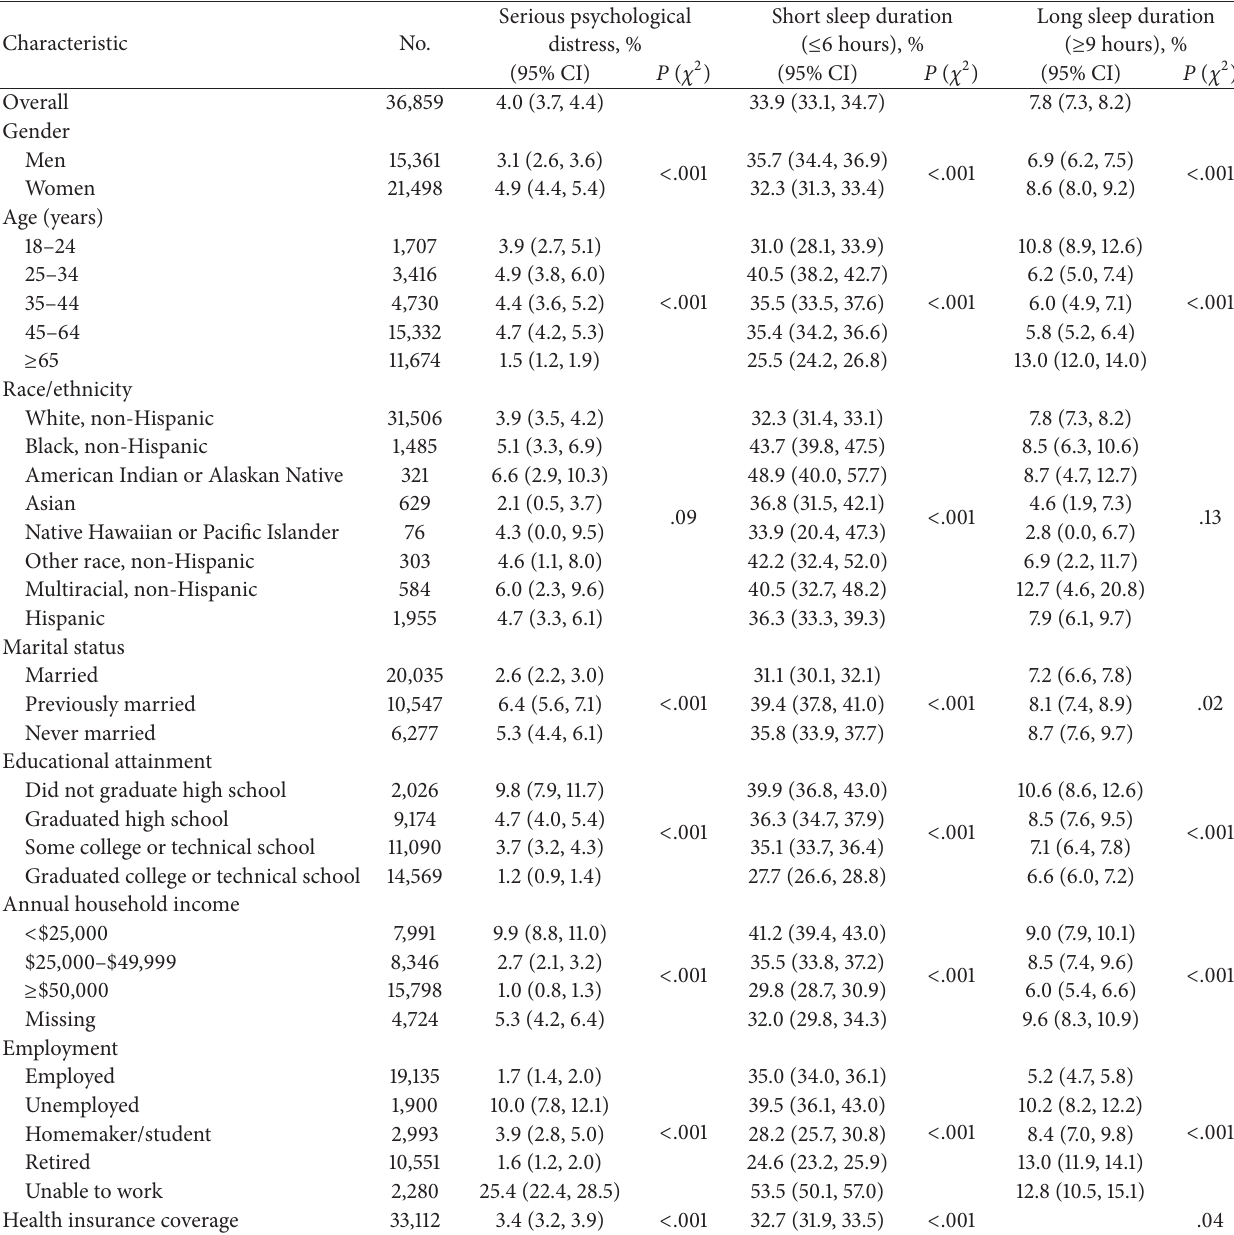
Table 1: Prevalence of serious psychological distress, short sleep duration, and long sleep duration, by selected sociodemographic characteristics among adults aged ≥ 18 years in 5 states: Behavioral Risk Factor Surveillance System,